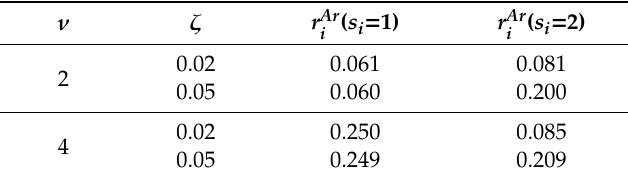
Table 5. Error ratio r Ar for di ff erent ν and ω i .